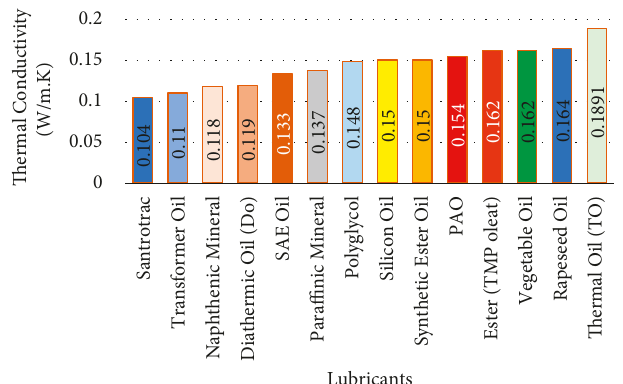
Figure 10: Thermal conductivities of various lubricants at 300 K [4, 214,